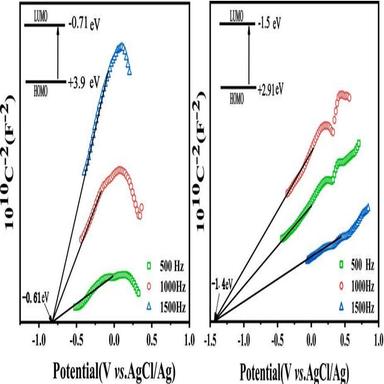
Mott-Schottky plots for (a) Fe-UiO-66 and (b) UiO-66 in a 0.1 M Na2SO4 aqueous solution (Insets: corresponding HOMO and LUMO levels, potential vs. NHE).